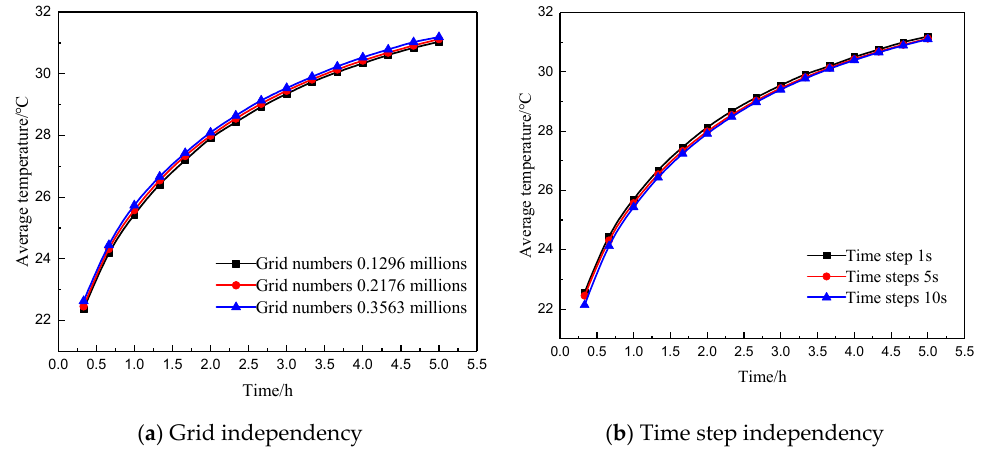
Figure 8. The grid and time step independence for the heat storage process.